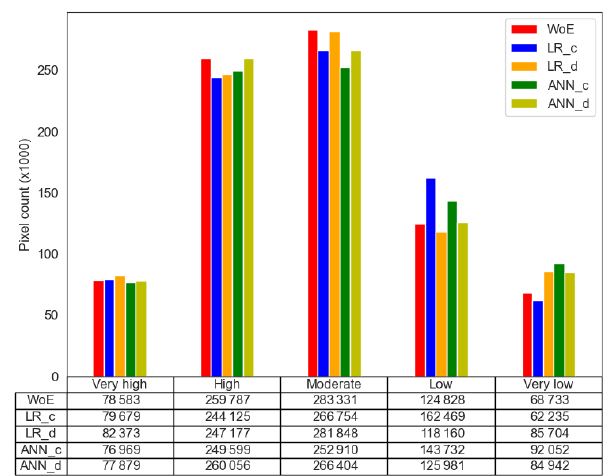
Figure 13. Susceptibility zone distributions for the susceptibility models. The values in columns show the number of pixels within the